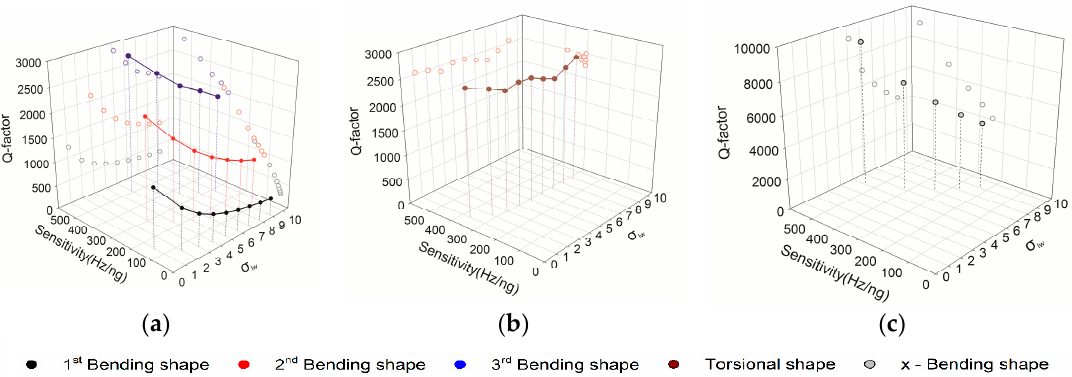
Figure 8. Q-factor variation of MCLs structural. ( a ) Q-factors of MCLs in z -Bending vibration mode, ( b ) Q-factors of MCLs in torsional vibration mode, ( c ) Q-factors of MCLs in x -Bending vibration mode. The line graph of the power dissipation corresponding to varying 𝜎 (cid:3039)(cid:3050) and resonant frequency